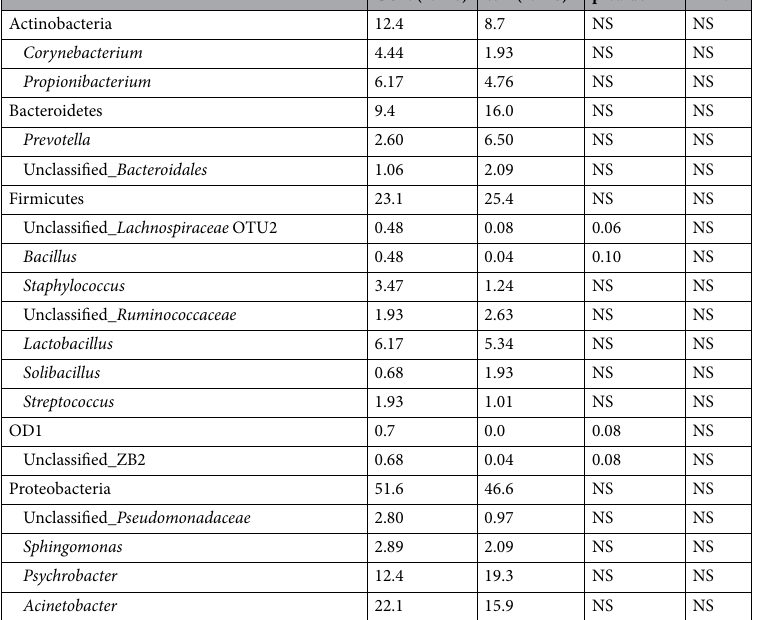
Table 2. Microbial composition of the umbilical cord blood of piglets born from sows fed the control diet (CON, N = 6) and the wheat bran-enriched diet (WB, N = 8), expressed as the percentage (%) of the total microbiota. Only top ten genera and those with a consistent p-value ( < 0.1) were included in the table.